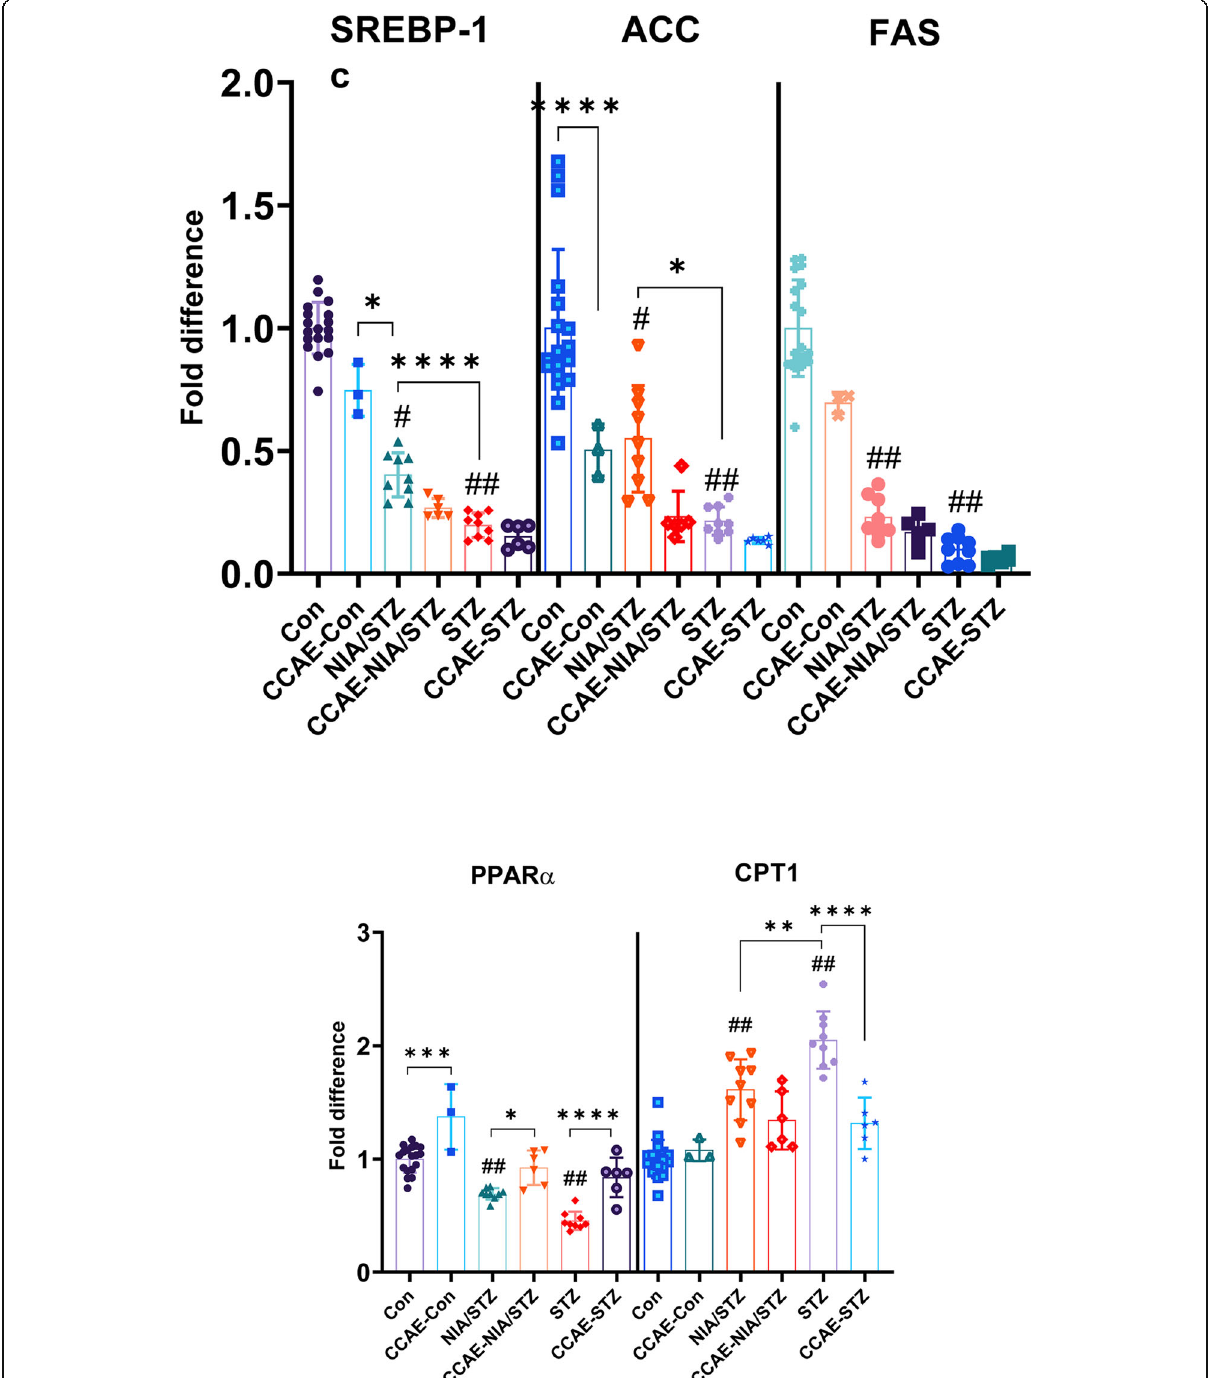
Fig. 5 Hepatic mRNA expression of SREBP-1c, ACC, FAS, PPAR α , and CPT1 on day 28. Con: nondiabetic control, CCAE-Con: nondiabetic control treated with CCAE, NIA/STZ: early-stage diabetic group, CCAE-NIA/STZ: the early-stage diabetic group treated with CCAE, STZ: late-stage diabetic group, CCAE-STZ: the late-stage diabetic group treated with CCAE. * p < 0.05; ** p < 0.01; *** p < 0.001. We have presented the data as the mean ± SEM. #, p < 0.05 and ##, p < 0.01 show significant differences between the diabetic group (STZ or NIA/STZ, respectively) versus